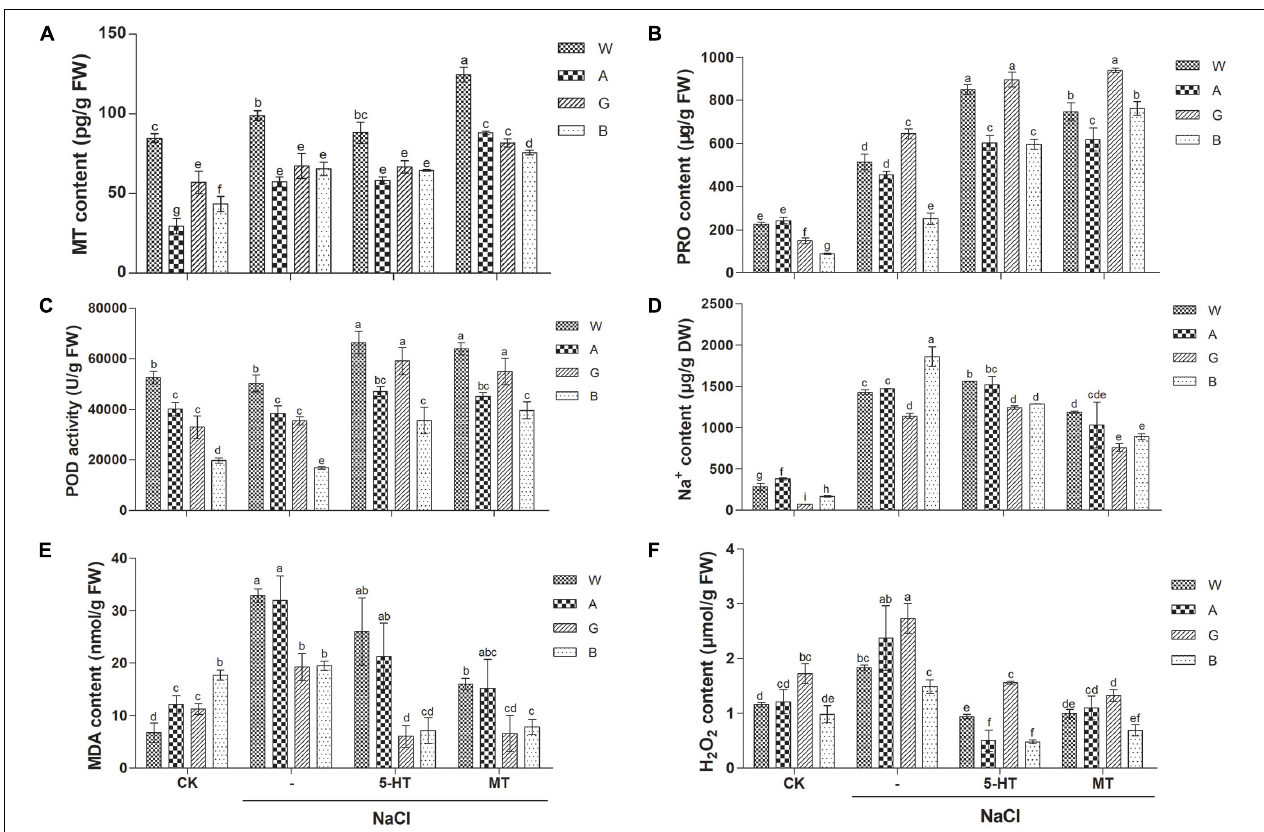
FIGURE 3 | Effects of MT and 5-HT treatment on MT content (A) , proline (PRO) content (B) , Peroxidase (POD activity) (C) , Na + content (D) , MDA level (E) , and H 2 O 2 level (F) of different alfalfa varieties under salt stress. n = 30–60. CK: Water. NaCl: 250 mM. MT: 150 µ M. 5-HT: 1 µ M. Seeds were germinated for 7 days under different treatments. About 0.01 g of oven-dried seedling was used for the measurement of Na + content and 0.1 g of fresh seedling was used for other measurements in each replicate. Error bars show the SE between biological replicates and a t -test was performed between different treatment groups. Different numbers indicated significant differences ( p (cid:53) 0.05) between samples. A, Algonquin; B, Bingchi; G, Golden Empress; W,